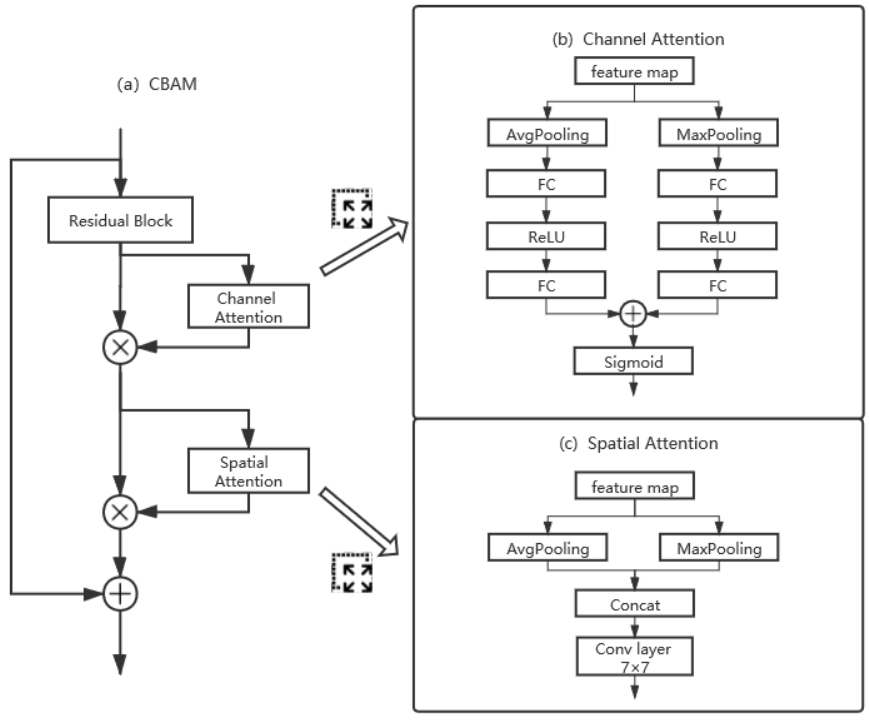
Figure 5. The structure of the attention blocks: ( a ) structure of CBAM, ( b ) structure of channel attention, ( c ) structure of spatial